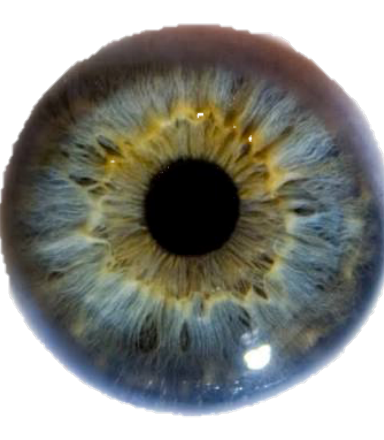
Figure 1: An example of eye